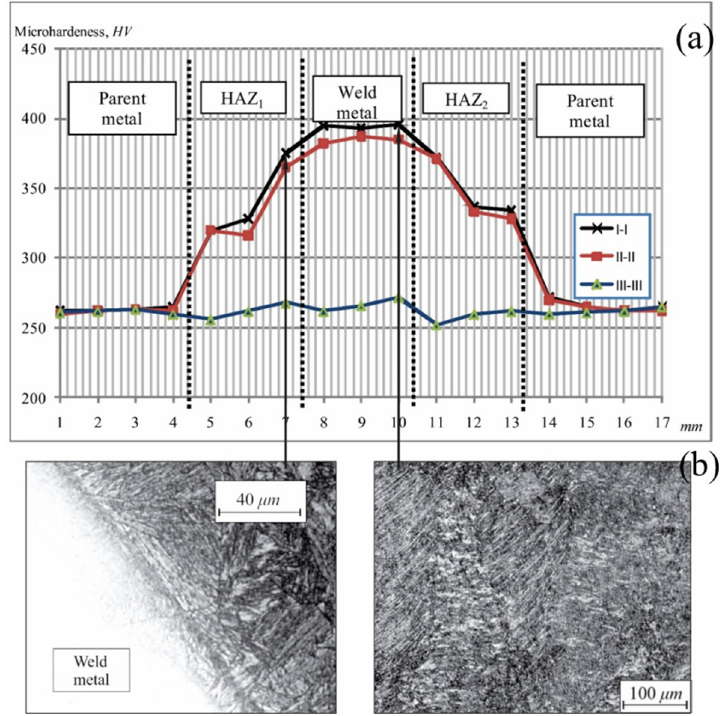
Figure 4. Micro hardness distribution and micro-structure of samples: ( a ) zone of transition between the weld metal and HAZ; ( b ) weld metal.